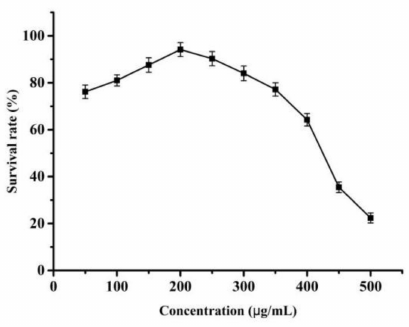
Figure 8. Effect of COSs nano-liposomes on the survival rate of Caco-2 cells model.